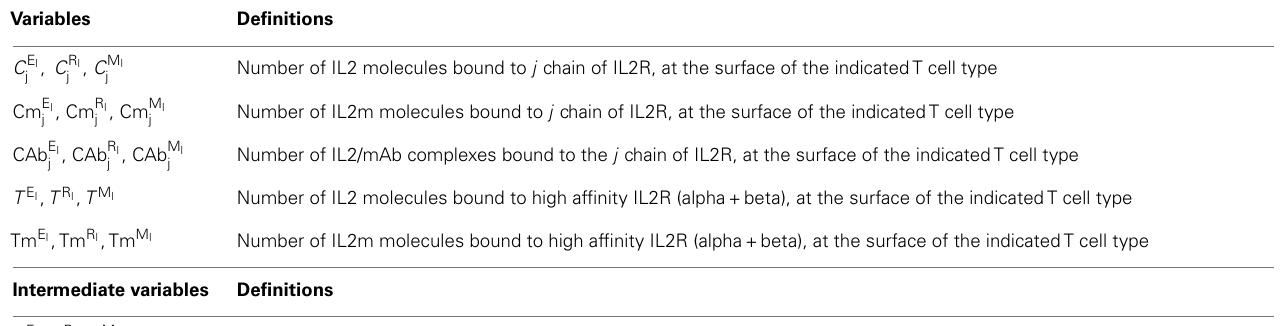
Table 3 |Variables and parameters related to dynamics of IL2, IL2R, and mAb complexes